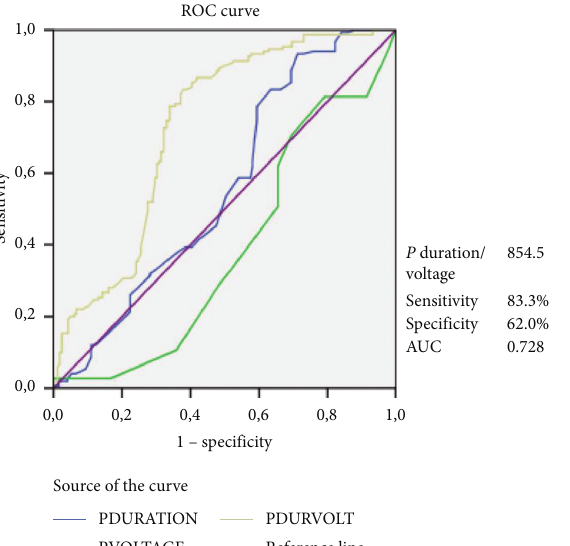
Figure 3: P wave duration/P wave voltage cutoff of 854.5 predicts new-onset AF, with a sensitivity of 83.3% and a specificity of 62.0%. The AUC of P wave duration is 0.561. The AUC of P wave voltage is 0.387. The AUC of P wave duration/P wave voltage ratio is 0.728. AF: atrial fibrillation, AUC: area under the curve, ROC: receiver operating characteristic. Diagonal segments are produced by ties.